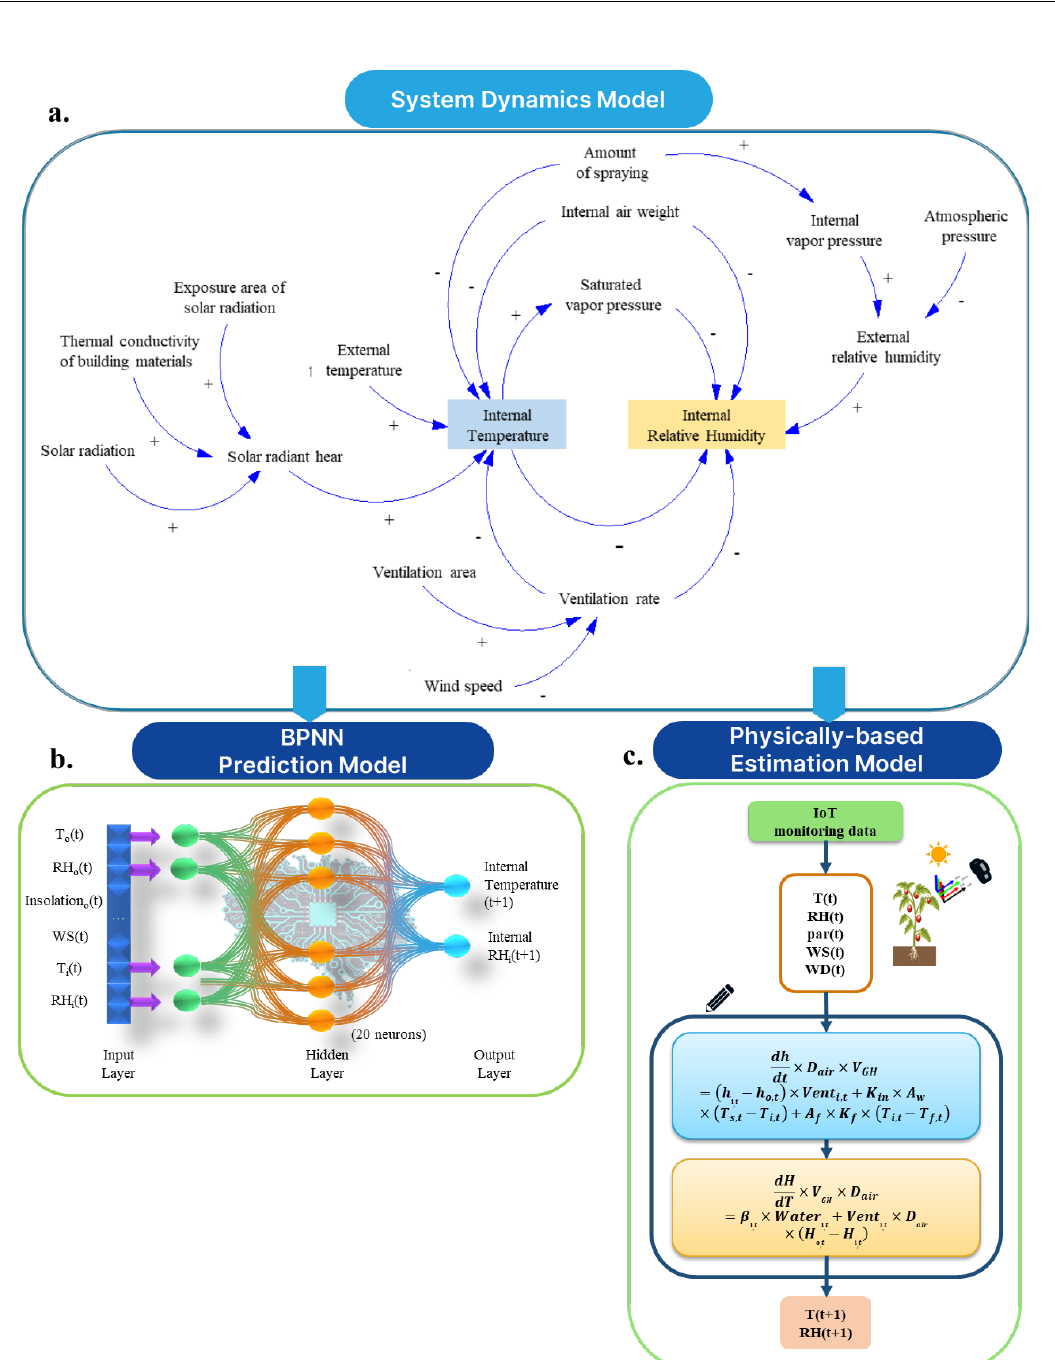
Figure 3. Model construction of the proposed smart microclimate-control system (SMCS) for green- house cultivation in consideration of the spray effect. ( a ). SD model. ( b ). BPNN prediction model. ( c ). Physically based estimation